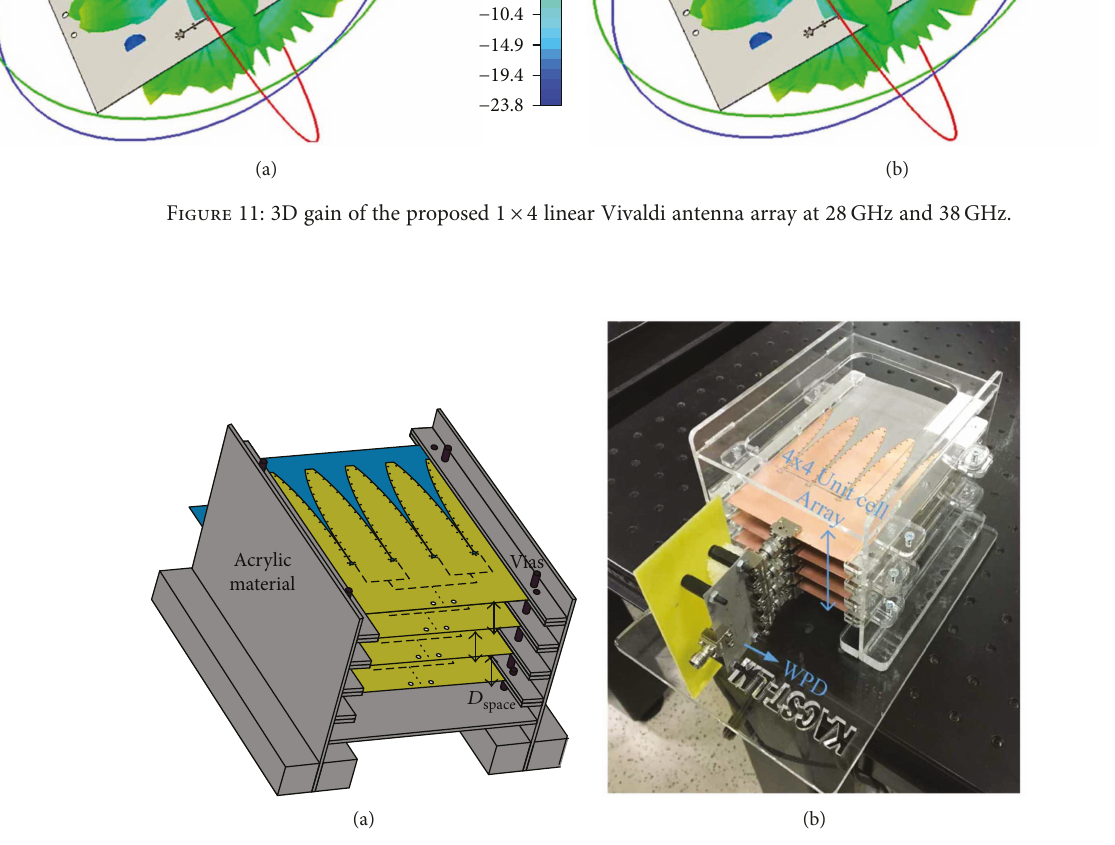
Figure 12: (a) Layout of acrylic box for placement of four 1 × 4 antenna arrays. (b) Prototype of the 4 × 4 antenna array unit